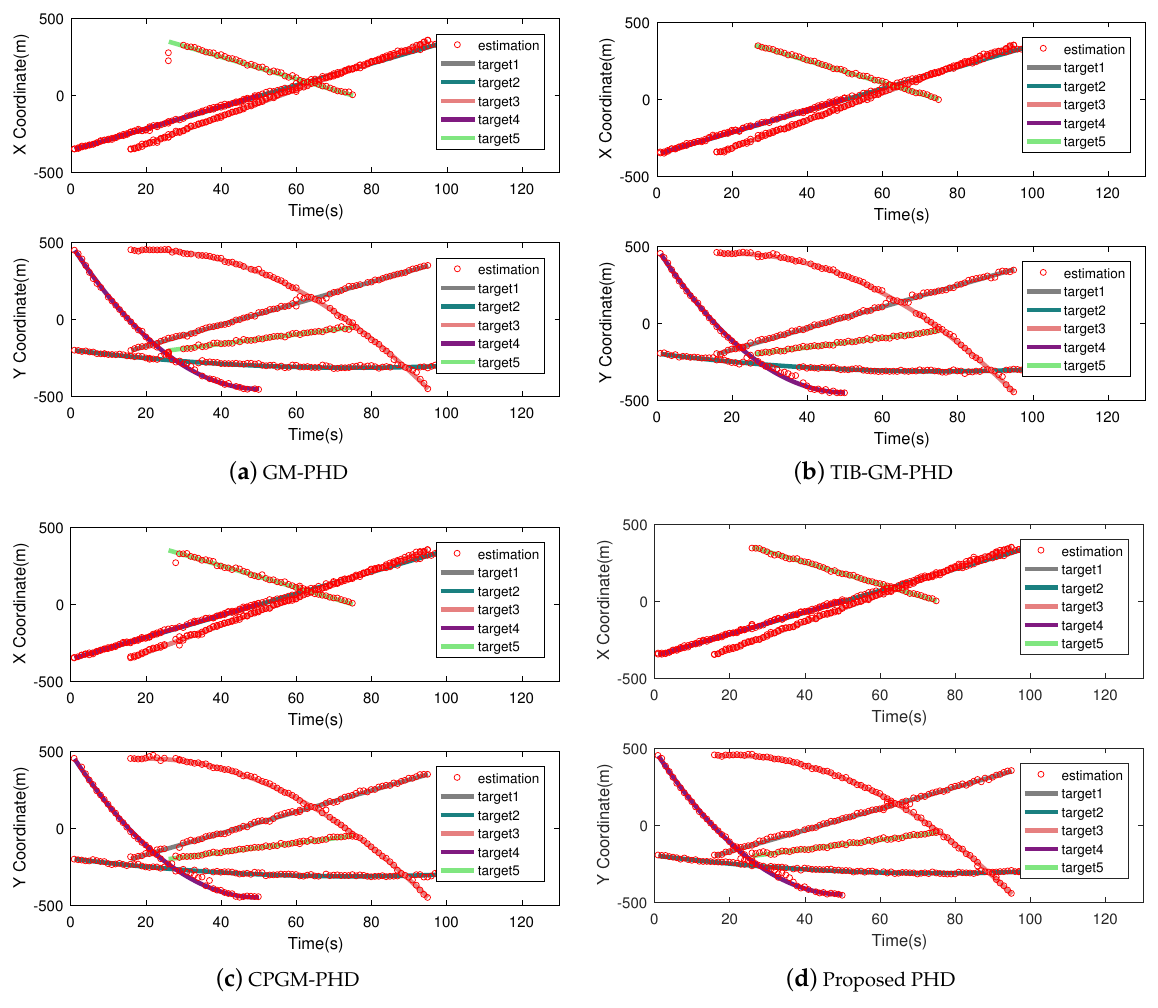
Figure 11. The position estimation of GM-PHD, TIB-GM-PHD, CPGM-PHD and Proposed PHD in the intersection